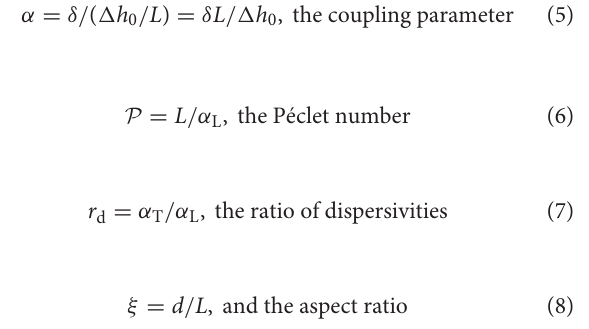
condition is seawater concentration c s over the part of inflowing seawater and advective transport ( ∂ c /∂ x = 0) on the part of outflowing brackish